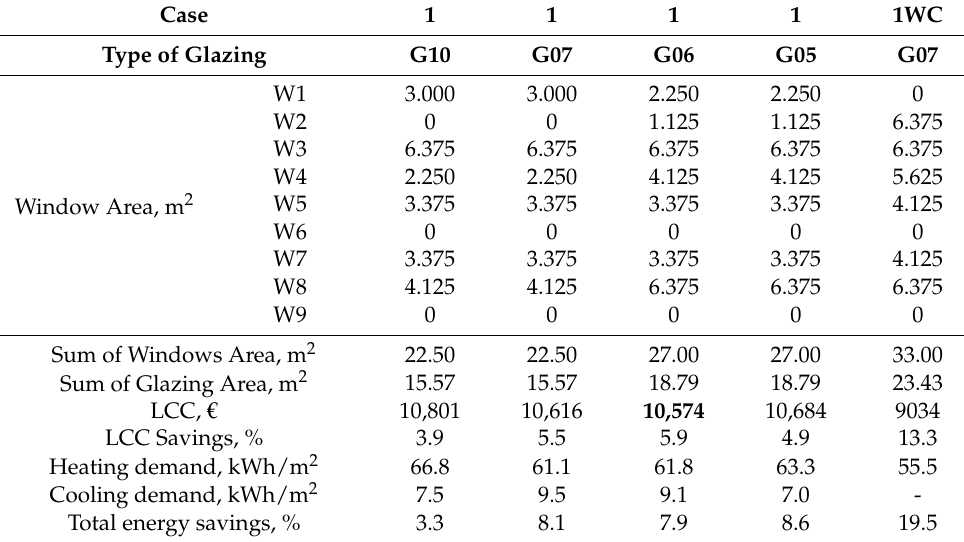
Table 7. Optimal results for case 1.